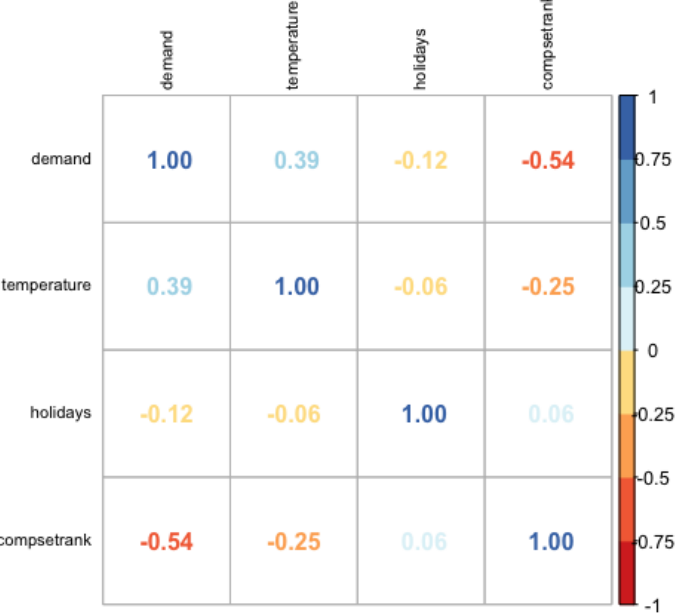
Figure 4. Dataset variables’